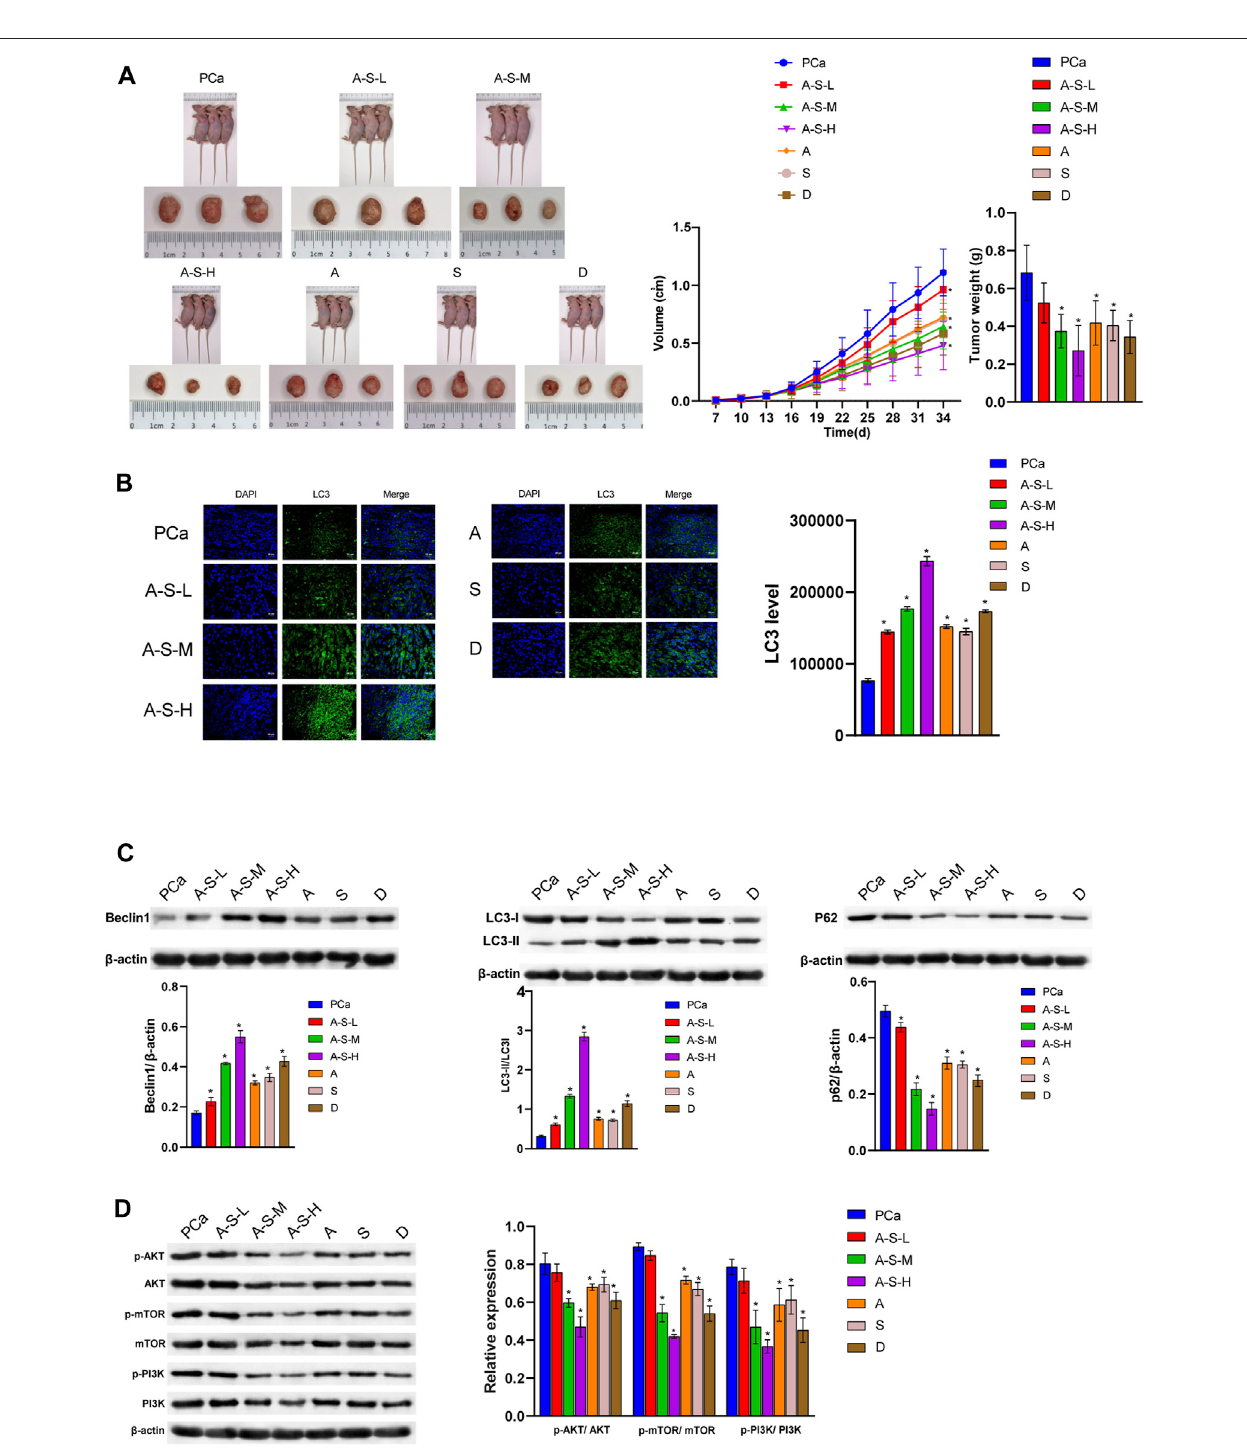
FIGURE 2 | A – S drug pair inhibited PCa development by inhibiting the PI3K – AKT/mTOR pathway. (A) LNCaP cells were injected subcutaneously into BABL/c nude mice ( n = 6), and the tumor volume and tumor weight were analyzed. (B) LC3 and DAPI immuno fl uorescence staining were performed to detect the LC3 expression. (C) The LC3, Beclin1, and P62 expression were determined by western blot. (D) The expression of the PI3K/AKT/mTOR pathway protein was analyzed by western blot. * p < 0.05 vs. control group.